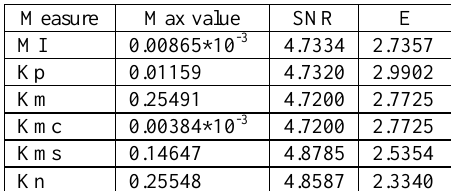
Table 1. Numeric data for TV-IR matching (Example 1).